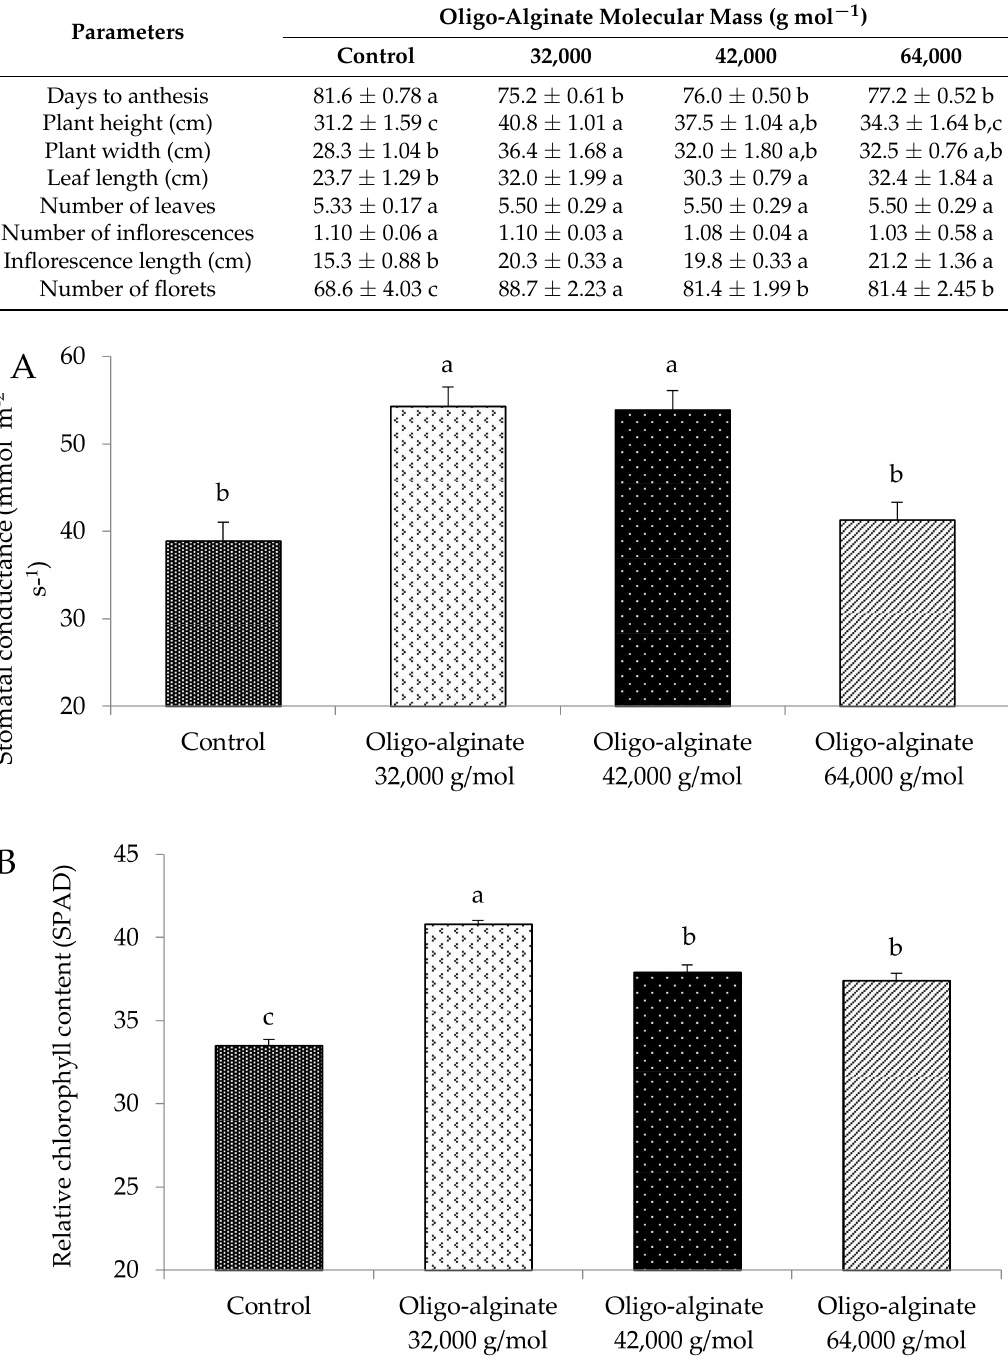
Table 1. Effect of oligo-alginate with different molecular mass on growth and flowering of Eucomis autumnalis . Means ( ± standard errors) followed by the same small letter in the same row did not differ by Tukey test ( p ≤ 0.05).